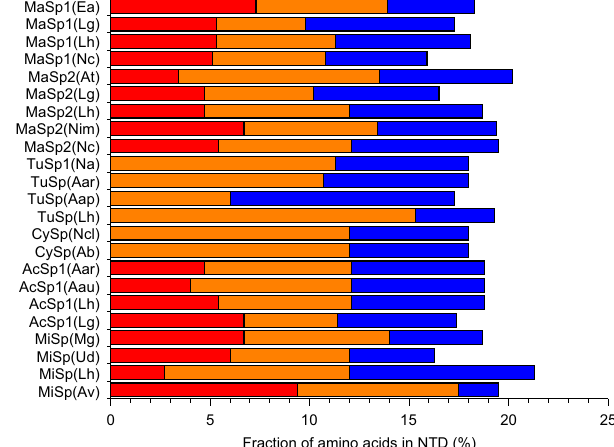
Fig. 8 Frequencies of Met (red), Leu (orange), and Ile (blue) in homologous spidroin NTD sequences (speci fi ed in Fig. 7)